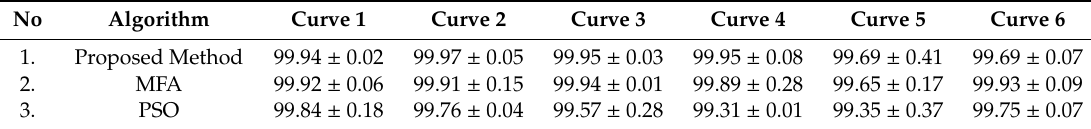
Table 4. Tracking e ffi ciencies by experiment.